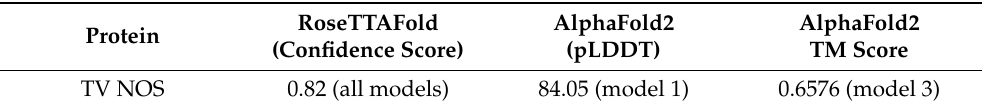
Figure 4. Prediction of three-dimensional conformation of TV NOS by using artificial intelligence programs. Note that the simulation by three-dimensional models predicted by ( A ) Alphafold2 and ( B ) RoseTTAFold was very similar. Table 1. Prediction of the 3D model of TV NOS in RoseTTAFold and AlpaFold2. Both proteins have no close homologs in the Protein Data Bank